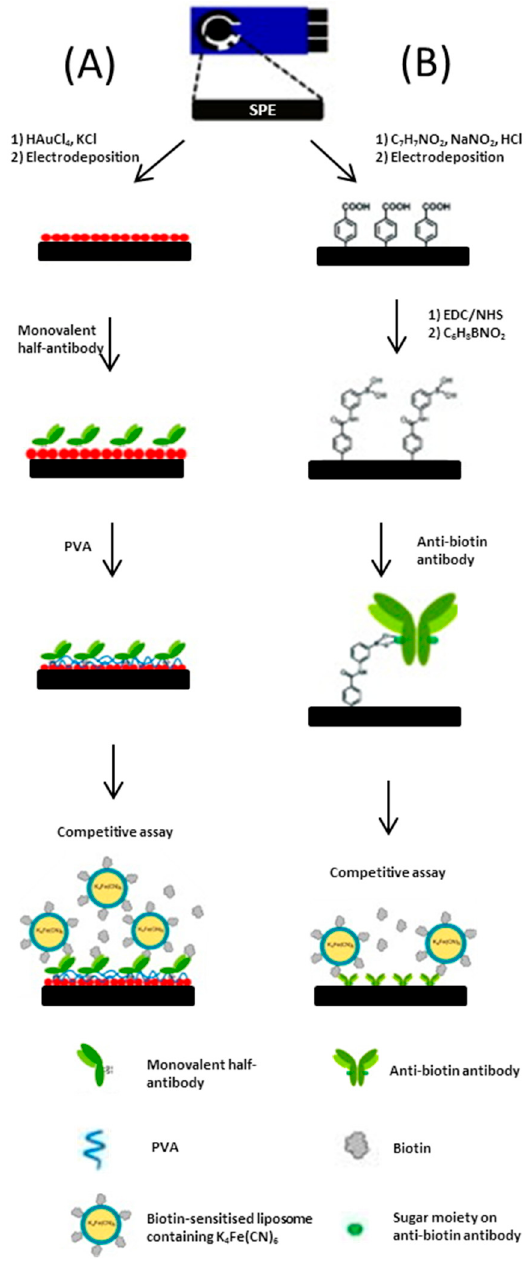
Figure 7. ( A ) Schematic representation of the method used to prepare a monovalent half-antibody/gold nanoparticles/screen printed graphene electrode electrochemical immunosensor and its mechanism of operation; ( B ) Schematic representation of the preparation of an antibody/anti-biotion antibody/screen printed graphene electrode electrochemical immunosensor and its mechanism of operation (drawing not to scale). Adapted from [57].